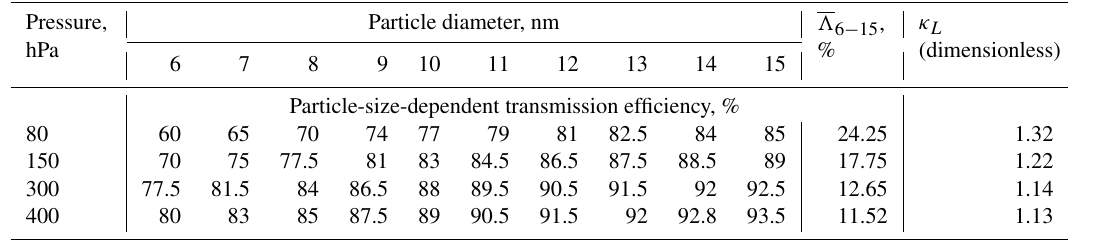
Table 1. Pressure-dependent corrections κ L for number concentrations of nucleation-mode particles due to particle losses ( (cid:51) 6 − 15 ) in the aerosol line configuration (both COPAS instruments attached to a single aerosol inlet) as deployed during StratoClim 2017 by using the particle loss calculator (von der Weiden et al., 2009) modified for low-pressure applications; κ L = 100 /( 100 − (cid:51) 6 − 15 ), corresponding to Weigel et al.